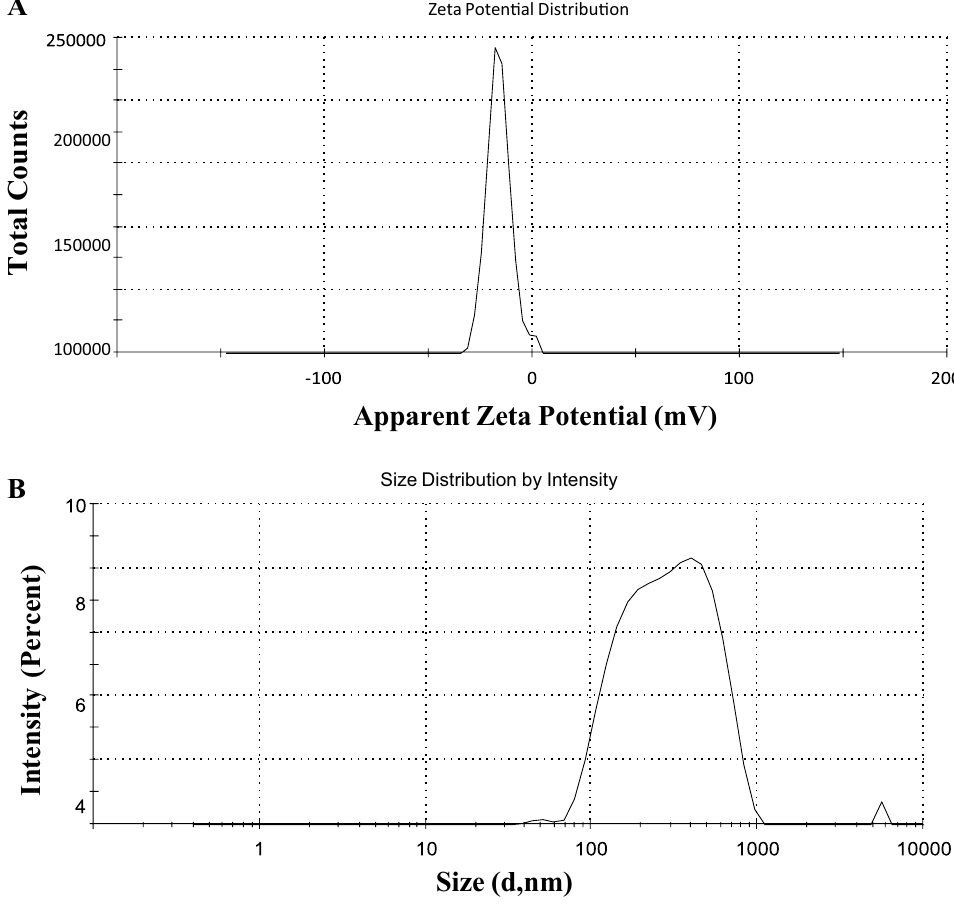
Figure 5. ( A ) Zeta Potential for Fe 2 O 3 synthesized nanoparticles. From the graphical result, the potential was found to be −16 mV which was a good indication for the formation of nanoparticles. ( B ) Zeta sizer for Fe 2 O 3 synthesized nanoparticles from Bauhinia tomentosa leaf extract.